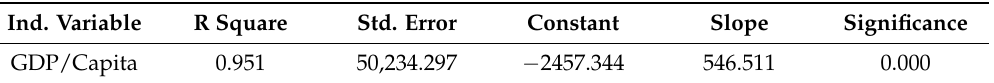
Table 3. Summary of the model with GDP per capita as the